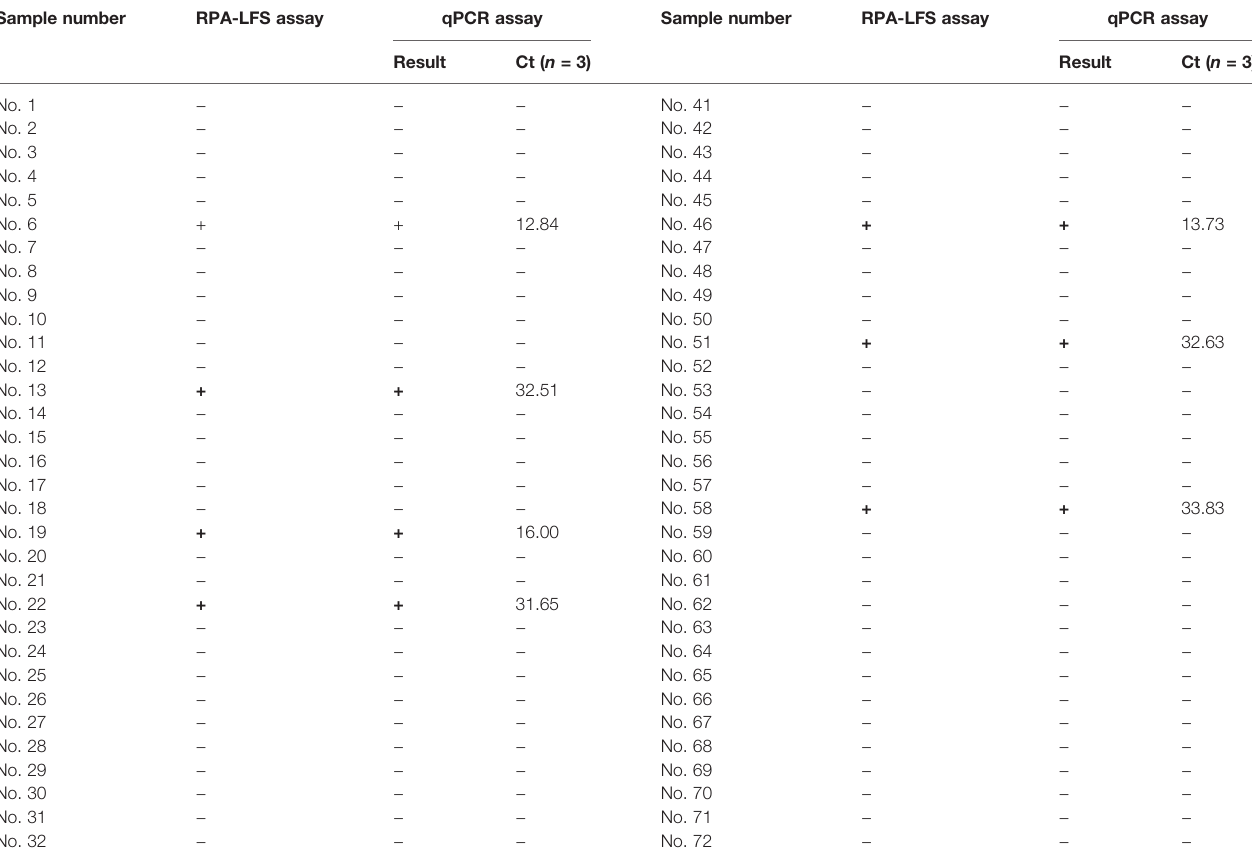
TABLE 2 | Detection of WSSV in clinical samples.